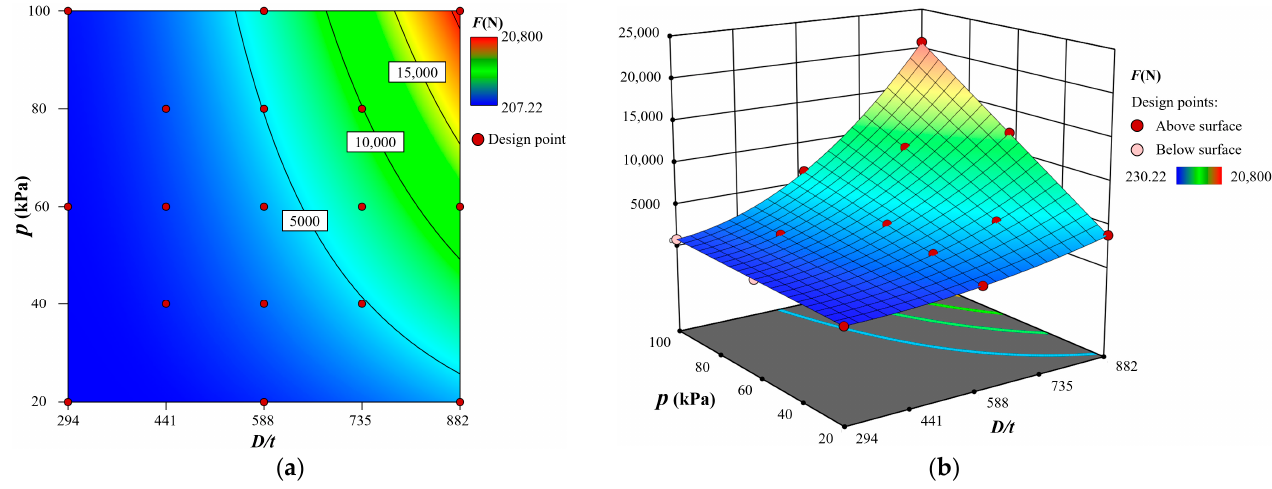
Figure 19. Response surface of the ultimate load for RC model: ( a ) contour plot related to the CCF-DoE design points; ( b ) 3D hyperplane of F about the design points within regressor variables space domain.